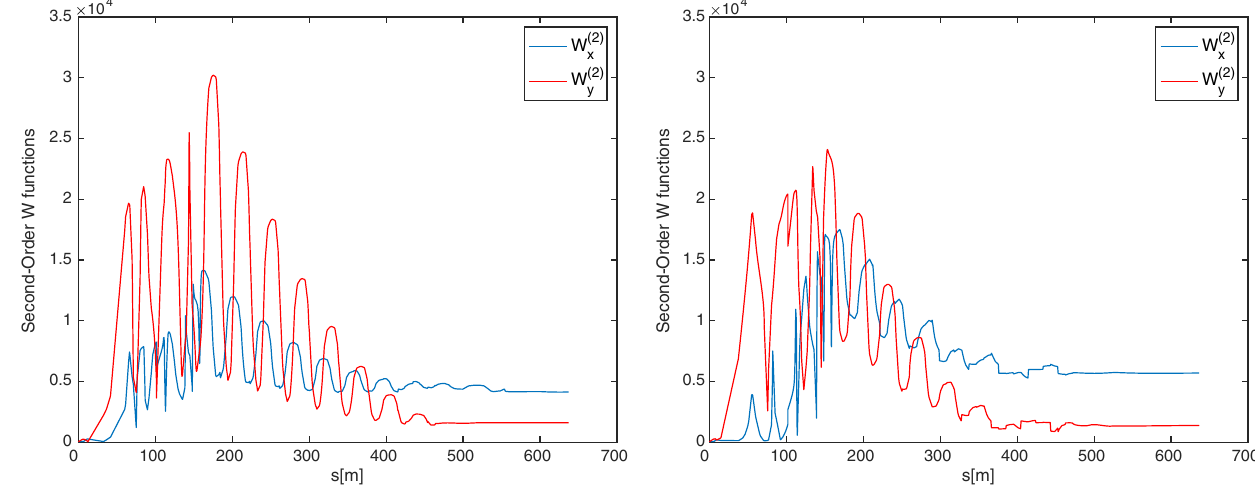
FIG. 7. Amplitudes of the second-order Montague functions in the upstream of the IR6 (left) and the downstream of the IR8 (right) using four families of sextupoles in the adjacent